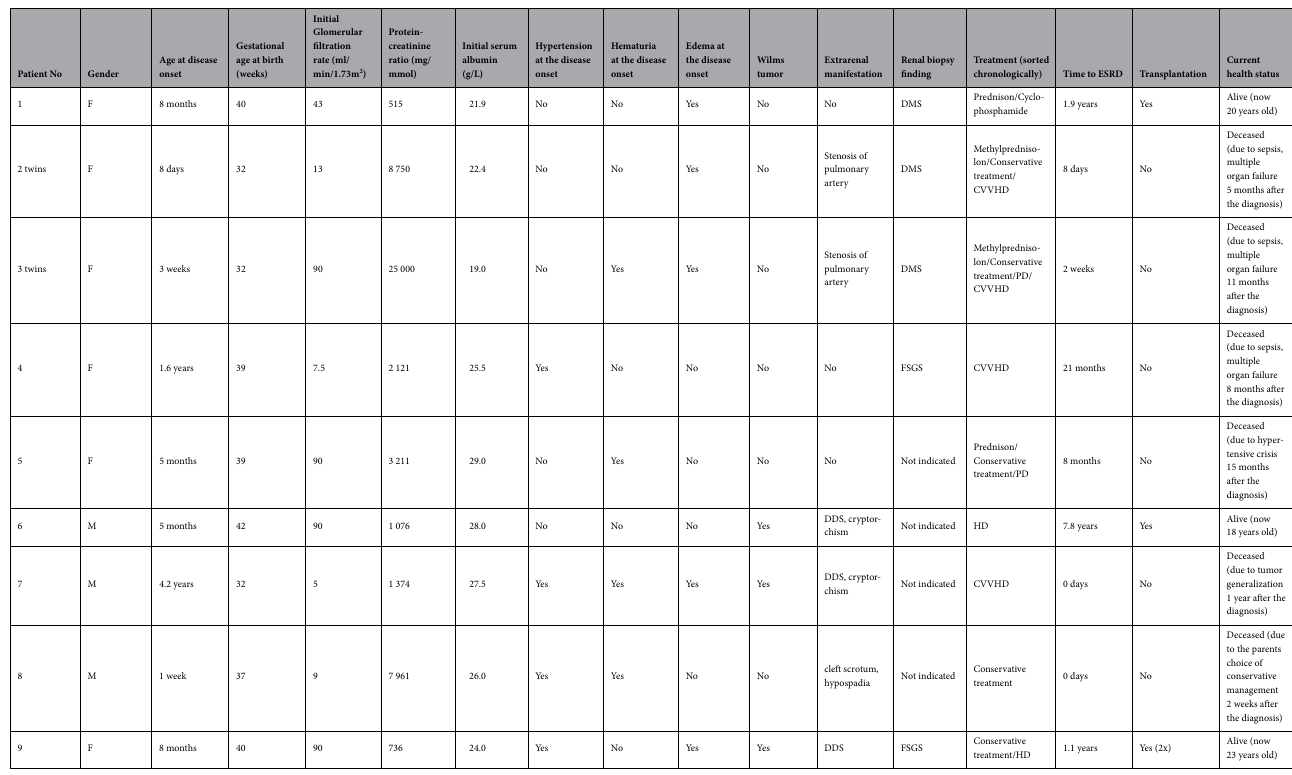
Table 1. Clinical characteristics of patients with WT1 variants. F = female; M = male; DDS = Denys- Drash syndrome; DMS = diffuse mesangial sclerosis; FSGS = focal segmental